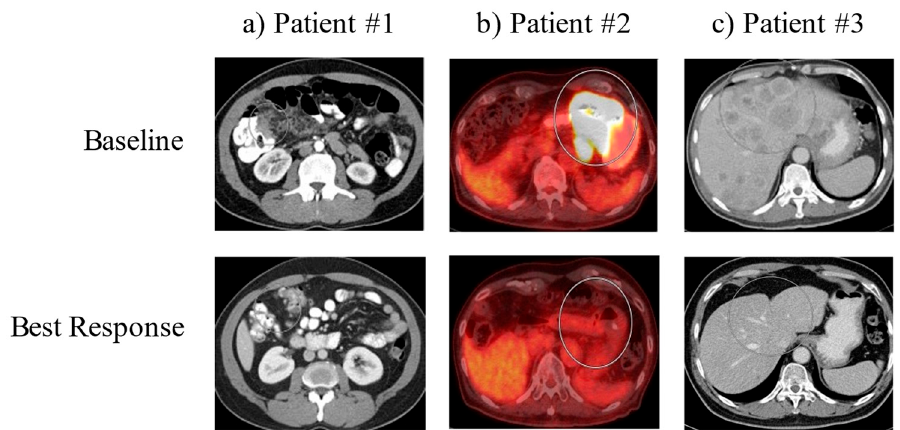
Figure 1. Baseline and best response imaging. Representative images of the tumors for each patient (in circles) are shown at the time of diagnosis (Upper Panel: ‘Baseline’) and at the time of maximum tumor shrinkage (Lower Panel: ‘Best Response’)